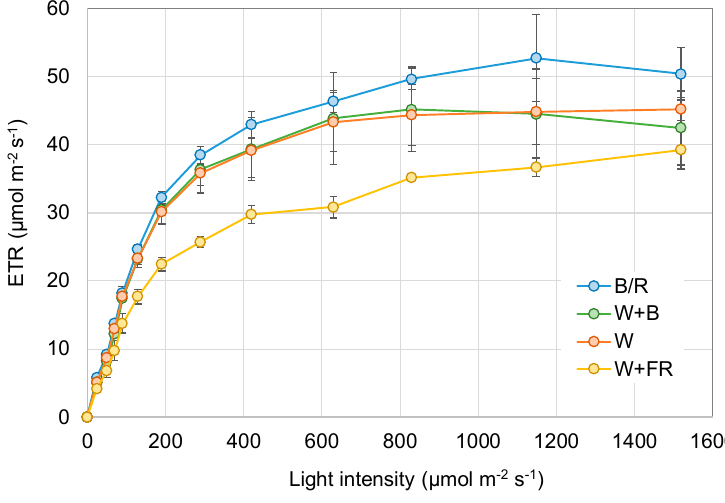
Figure 6. Results of instant light-response curves with an adaption time of 30 s of chlorophyll fluorescence measurement on marjoram leaves ( n = 3) grown under different LED treatment.